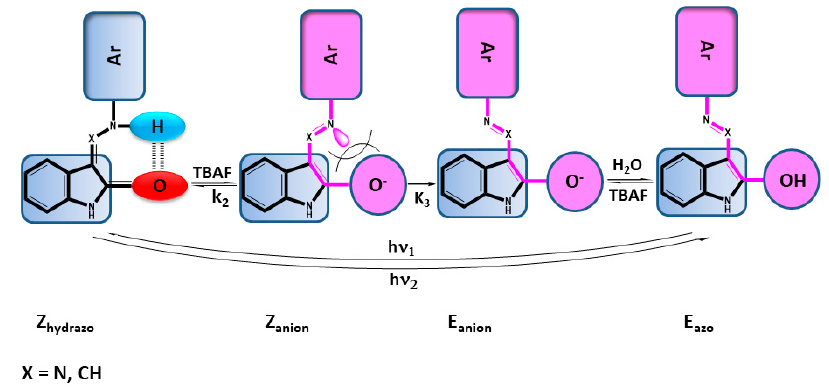
Scheme 9. Schematic representation of studied nitro compounds ON / OFF functionality.